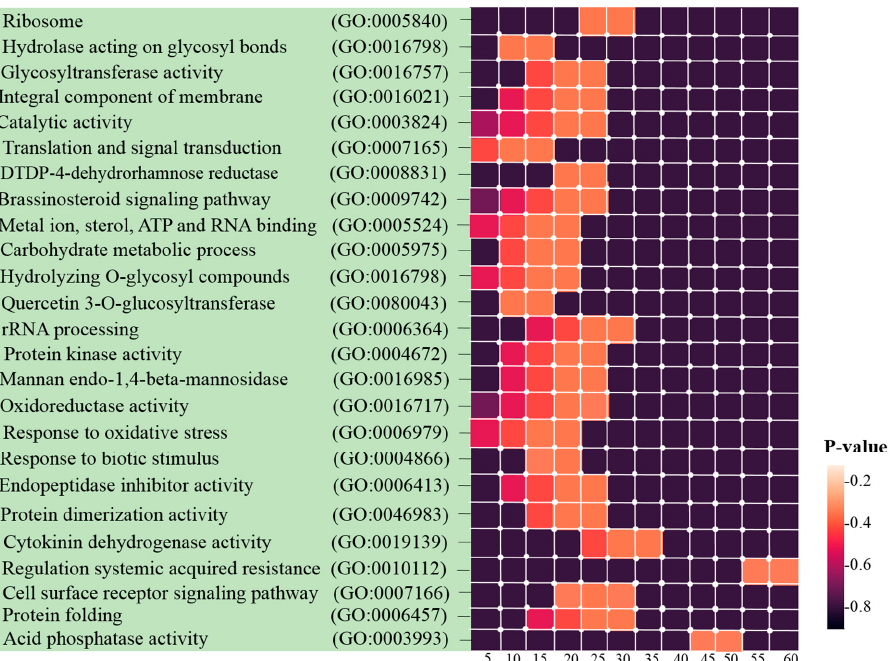
Figure 5. Binder and heatmap plots for the Gene Ontology analysis. GO enrichment analysis of hub genes was retrieved using DAVID. The most significantly ( p ≤ 0.05) enriched GO terms in biological process (BP) branches related to defense responses to drought are presented. The horizontal axis shows the number of genes based on the p- value, while the vertical axis represents the GO terms.